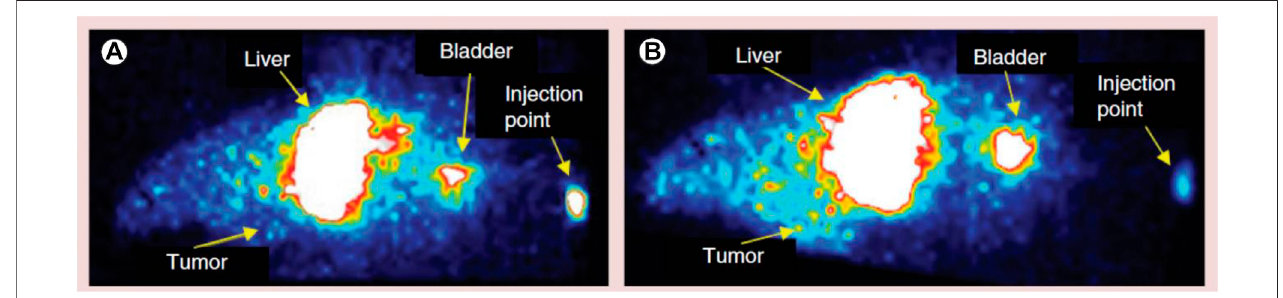
FIGURE8| Comparativeimageofatumor-bearingmouseinjectedwithdifferentpolymericnanoparticleformulations. (A) Silver-polymericnanoparticles- 99m Tcand (B) silver/alisertib-polymeric nanoparticles – chlorotoxin- 99m Tc post-injection. Reproduced from open-access Journal under the term of Creative Commons Attribution (Locatelli et al.,